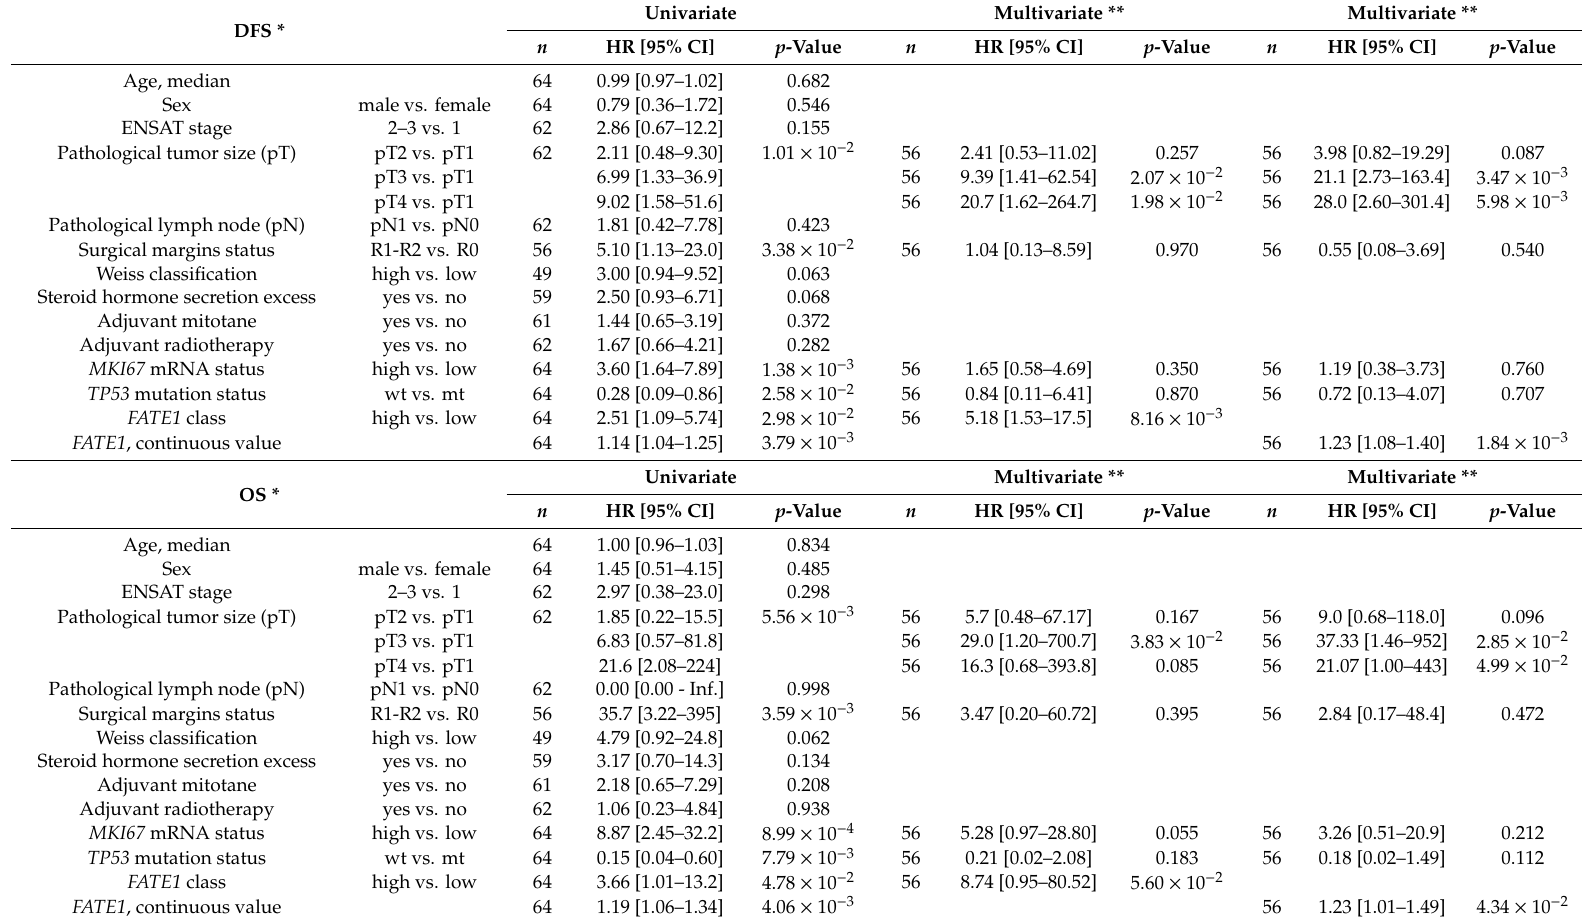
Table 3. Univariate and multivariate prognostic analyses for DFS and OS in adult M0 ACC patients from